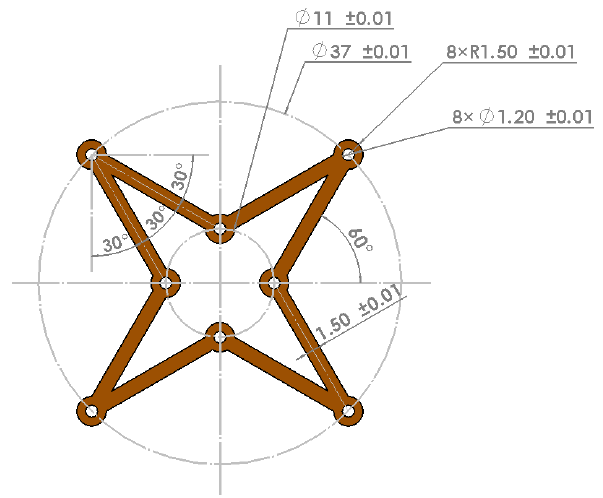
Figure 1. Four V-shaped leaf springs.